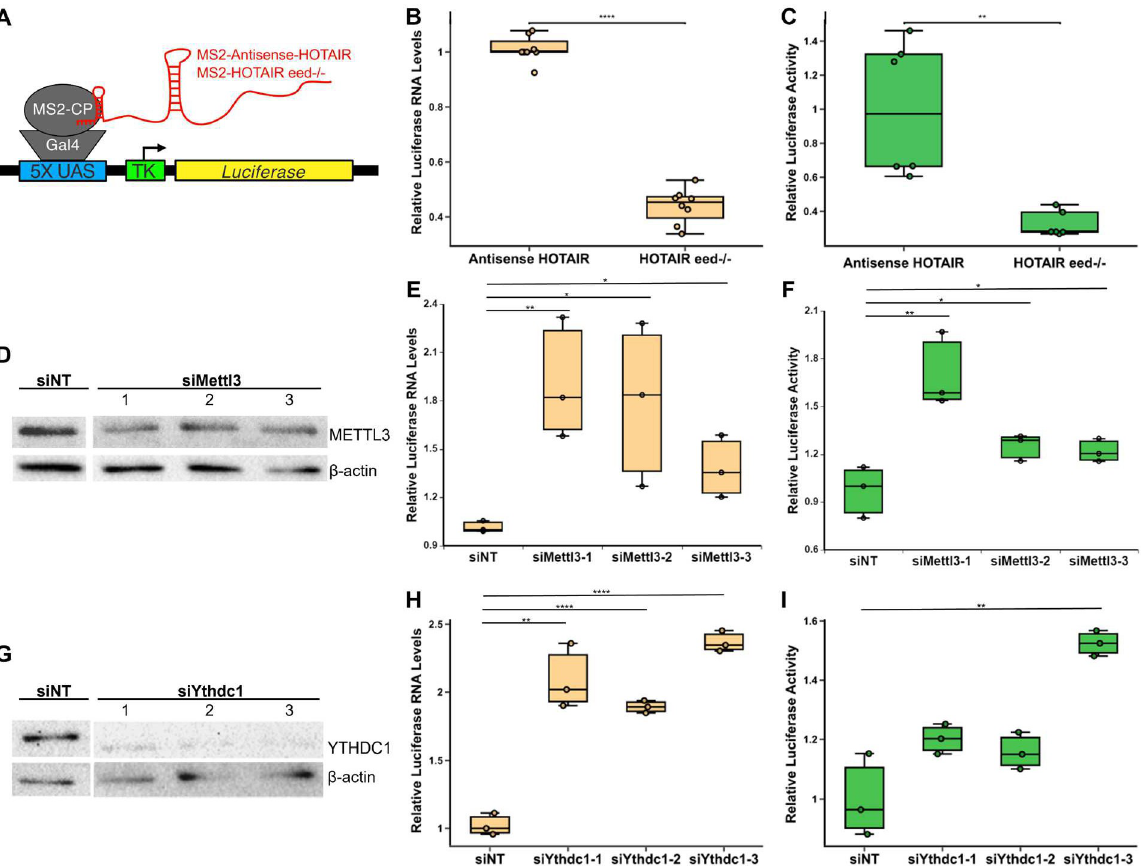
Fig 4. YTHDC1 mediates transcriptional repression by HOTAIR. (A) Schematic of 293T cells containing MS2-Antisense-HOTAIR or MS2-HOTAIR tethered upstream of a luciferase reporter. MS2-HOTAIR tethered cells also contain a deletion of EED , a subunit of PRC2 that is critical for H3K27 methylation. (B, C) Relative luciferase RNA levels (B) and relative luciferase activity (C) in MS2-Antisense HOTAIR or MS2-HOTAIR eed-/- cell lines. Six biological replicates were performed. (D) Western blot of METTL3 in MS2-HOTAIR eed-/- 293T reporter cells transfected with non-targeting siRNA or 3 different siRNAs targeting METTL3. (E, F) Relative luciferase RNA levels (E) and relative luciferase activity (F) of HOTAIR-tethered eed-/- cells transfected with a non-targeting siRNA or 3 different siRNAs against METTL3. Three biological replicates were performed for each experiment. (G) Western blot of YTHDC1 in MS2-HOTAIR eed-/- 293T reporter cells transfected with non-targeting siRNA or 3 different siRNAs targeting YTHDC1. (H, I) Relative luciferase RNA levels (E) and relative luciferase activity (F) of HOTAIR-tethered eed-/- cells transfected with a non-targeting siRNA or 3 different siRNAs against YTHDC1. Three biological replicates were performed for each experiment. Numerical values in panels 4B–C, 4E–F, 4H–I are included in S2 Data. siRNA, small interfering RNA.